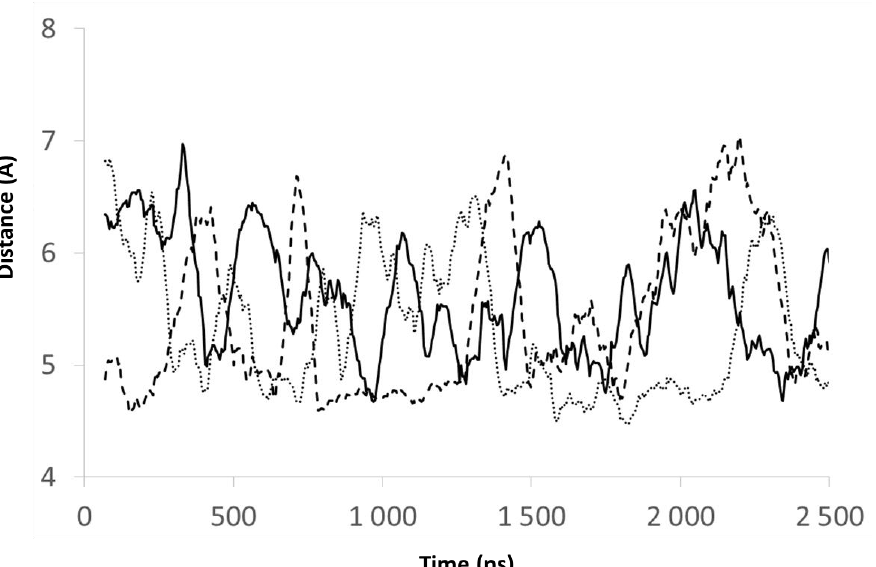
Figure 8. Time evolution of the distance between the gadolinium center and the three water molecules; each curve corresponding to one given water molecule.